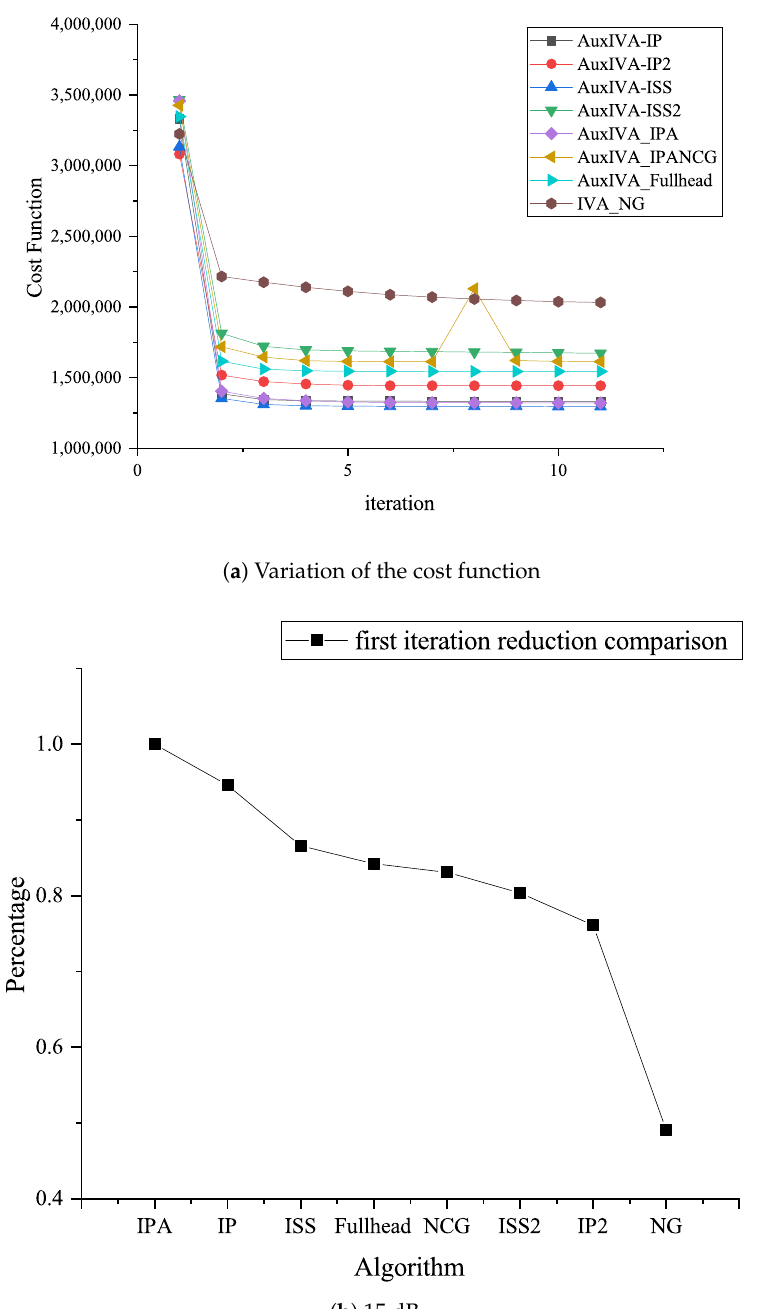
Figure 13. Cost function comparison at 5 dB. Figure 14 is the separation effect diagram of different methods in the 5 dB environment;